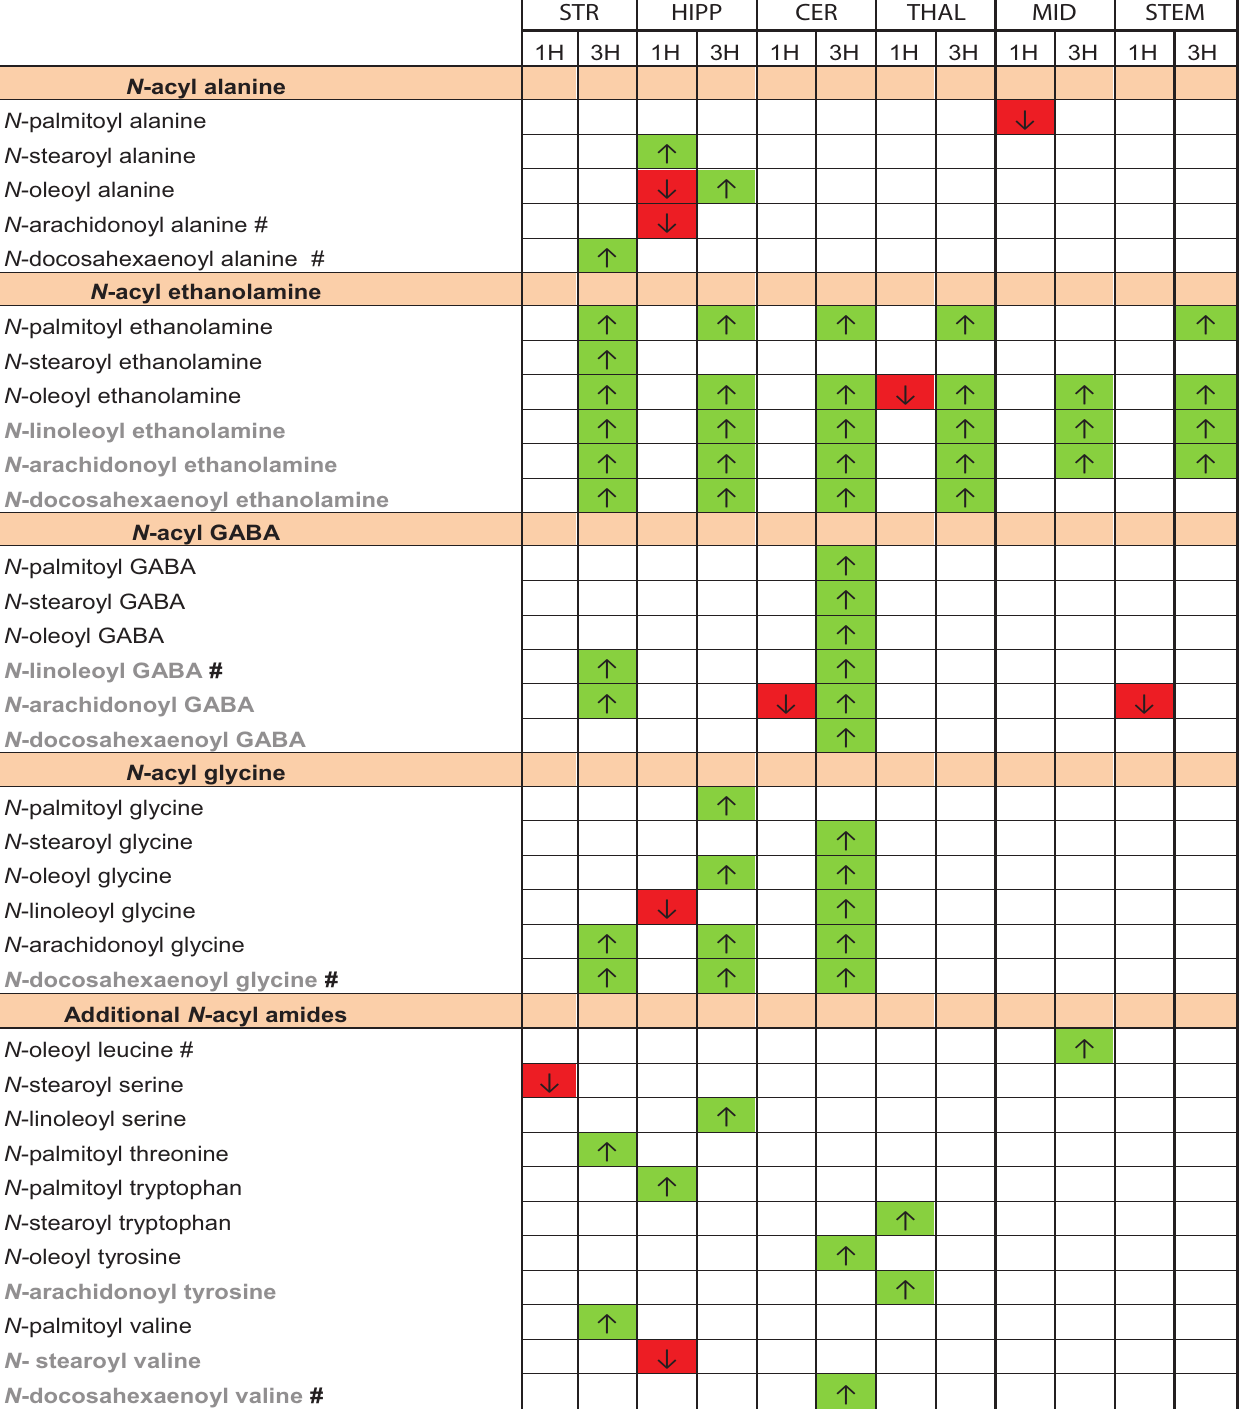
Table 3 | Effects on N -acyl amide lipidomics profile in 6 brain areas 1 and 3h post